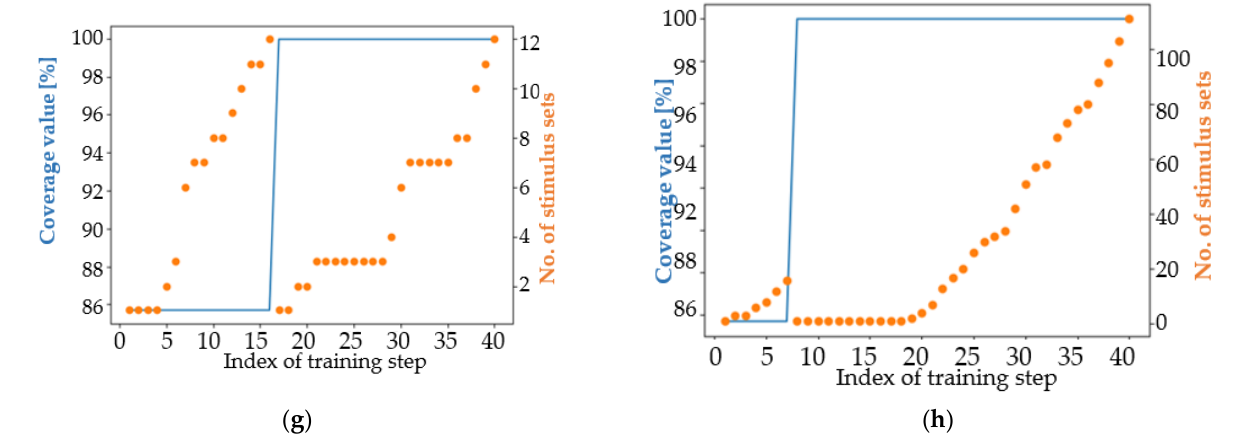
Figure 15. Plots representing the outcome of the genetic algorithm-based approaches used for the easy coverage target. The label “proposed” is attached to plots related to the approaches developed and proposed during current study. The blue line shows the coverage value reached by the best performing element in the population at that training step. The orange dots show how many individuals reached the highest coverage value met at each training step. For sub-figures ( c , e , f ), the best individuals in the initial population reached 71.4% coverage. For sub-figure ( a , b , d , g , h ), the best individuals in the populations at each training step reached 85.7% coverage. ( a ) V3.2 (proposed); ( b ) V3.21 (proposed); ( c ) V3.3 (proposed); ( d ) V3.6 (proposed); ( e ) classical NSGA-II [29]; ( f ) classical- modified NSGA-II [31]; ( g ) modified NSGA-II [31]; ( h ) SPEA2 [40] — Trial I.